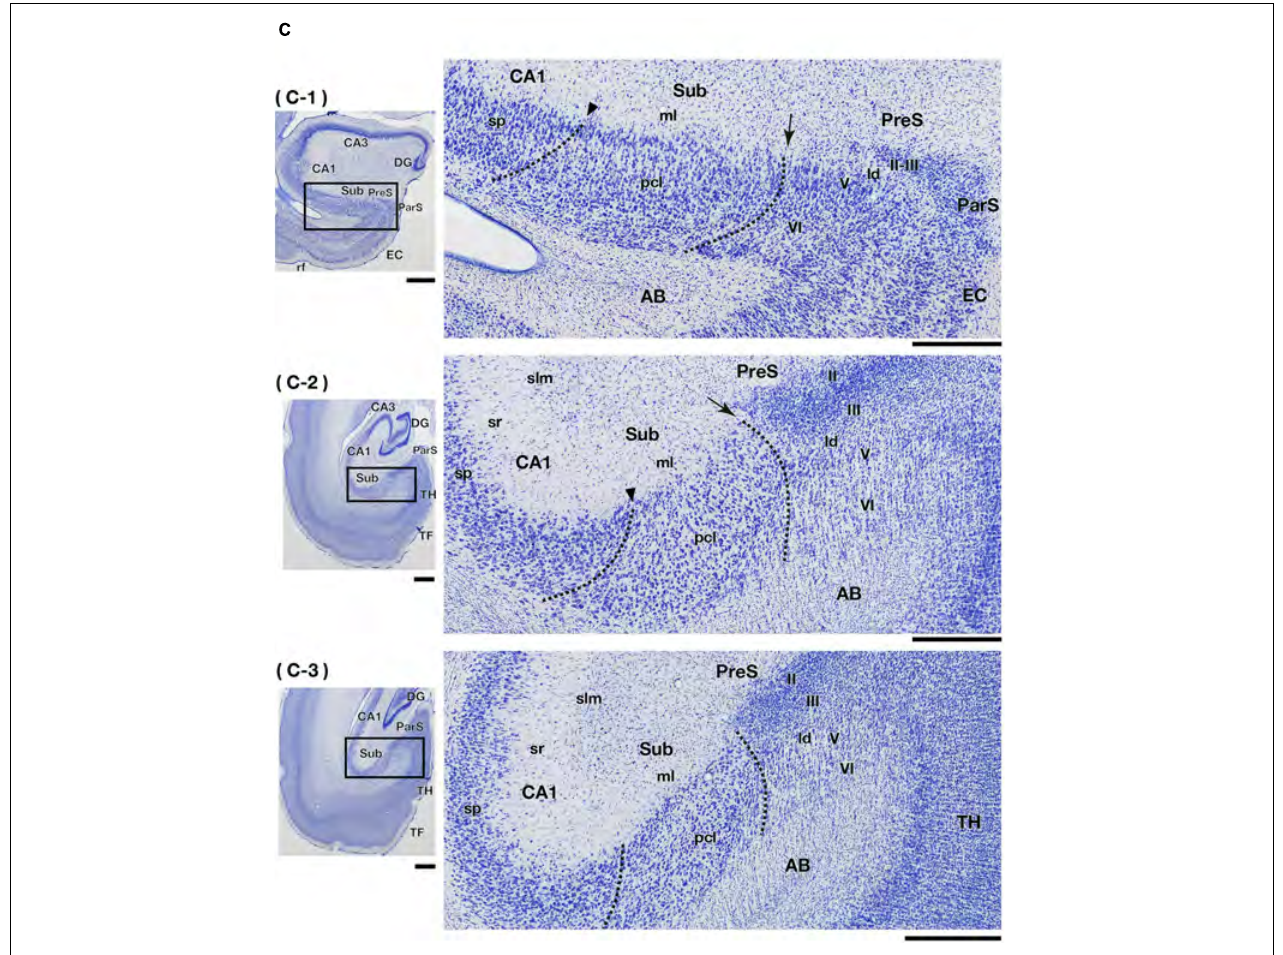
FIGURE 1 | Cytoarchitecture and positional relationships of hippocampal and parahippocampal areas in the marmoset. (A) Photomicrograph of a frontal section including the hippocampal formation and some parahippocampal areas (PreS, ParS, and EC). Black arrowheads indicate the boundaries between areas at their surface level (just beneath the molecular layer). The asterisk indicates the position of presumptive CA2. The black dotted line indicates the boundary between Sub and PreS, and the black arrow indicates the origin of the y-axis of the two-dimensional unfolded map in panel (B) . Colored dotted arrows indicate the proximodistal extent of each area from the Sub/Pre boundary to the proximal edge of CA3 (as indicated by P within the circle) or to the rhinal fissure, i.e., the distal edge of EC (as indicated by D within the circle). Scale bar = 1 mm. (B) An example of a two-dimensional unfolded map of the hippocampal and parahippocampal areas. The Sub/PreS boundary is set as the zero-point of the y-axis, and colored dotted arrows indicate the length of each region within one frontal section that corresponds with (A) . Gray dotted lines indicate the rostrocaudal level of the sections shown in panel (C) . (C) Photomicrographs of frontal sections of three different rostrocaudal levels at an interval of 1.6 mm (between c-1 and c-2) or 1 mm (between c-2 and c-3), as indicated in panel (B) . The enlarged photomicrograph of the rectangle in each left panel is shown in the right row. Arrows and arrowheads indicate the surface point of Sub/PreS and CA1/Sub boundary, respectively. Dotted lines indicate the presumptive boundaries between CA1/Sub and Sub/PreS in each section. Scale bars = 1 mm in the left panels and 500 µ m in the right panels. A35/36, areas 35 and 36 (the perirhinal cortex); AB, angular bundle; CA, cornu ammonis; D, distal; DG, dentate gyrus; EC, entorhinal cortex; fim, fimbria; ld, lamina dissecans; ml, molecular layer; P, proximal; ParS, parasubiculum; pcl, pyramidal cell layer; PreS, presubiculum; rf, rhinal fissure; slm, stratum lacunosum-moleculare; so, stratum oriens; sp, stratum pyramidale; sr, stratum radiatum; Sub, subiculum; TF, area TF; TH, area